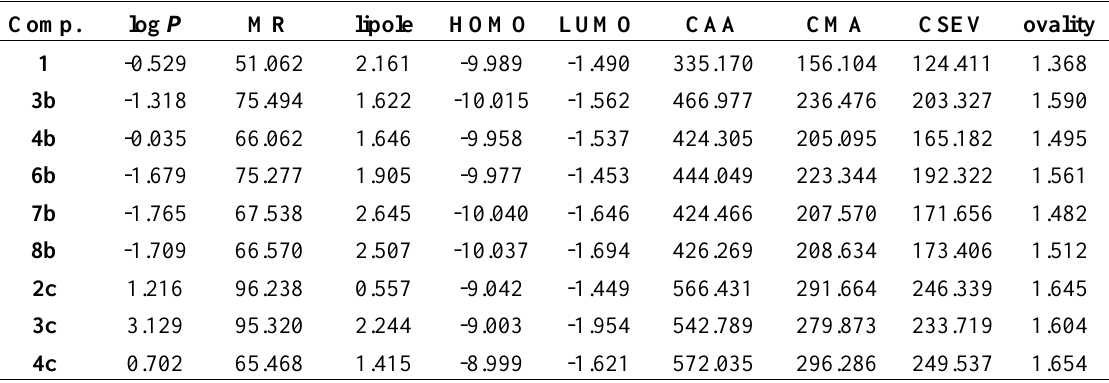
Table 2. Relevant calculated physico-chemical parameters of synthesized 4-hydroxy- coumarin